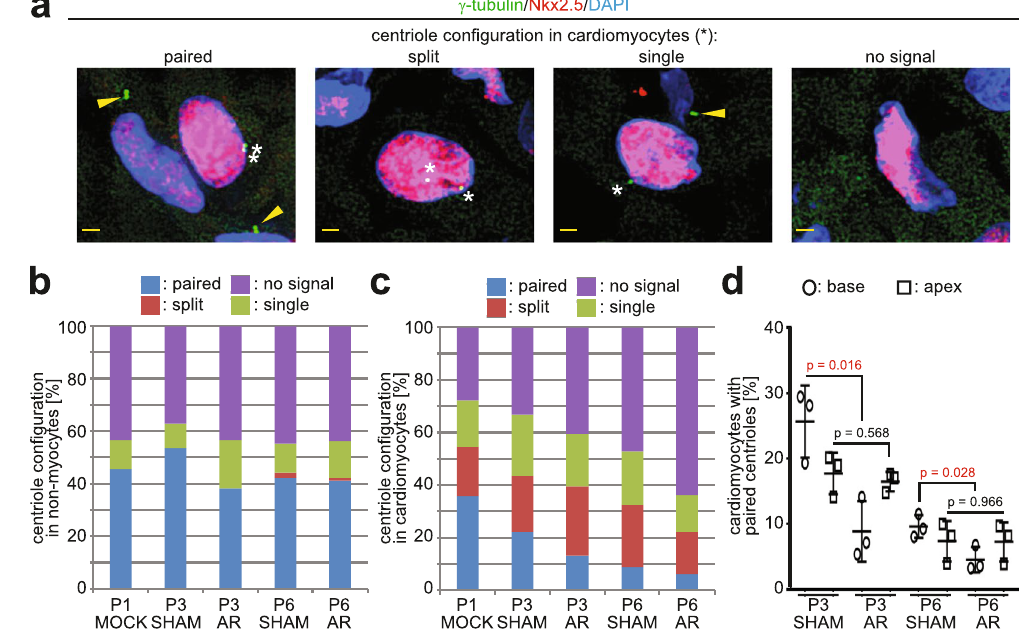
Figure 1. Effect of AR on cardiomyocyte centrosome disassembly. ( a ) Representative images of centrioles ( γ -tubulin) in heart cryosections of P0 rat heart ventricles. Nuclei: DAPI. Cardiac nuclei: Nkx2.5. Arrowheads indicate paired centrioles in non-myocytes. Asterisk indicates centrioles in cardiomyocytes. Paired-centrioles: doublet γ -tubulin signals within 2 μ m of one another; split-centrioles: γ -tubulin signals greater than 2 μ m of one another; single-centriole: single γ -tubulin signal with no identifiable pair (e.g. other centriole is either overlapping or split to the extent of no longer residing in the section); no-centriole: no identifiable, nuclear- proximal, γ -tubulin signal in the section. Scale bars: 2 μ m. ( b , c ) Quantitative analysis of centriole signals and configurations in non-myocytes ( b ) and cardiomyocytes ( c ) from cryosections of P0 (MOCK) and P3 or P6 (SHAM and AR) rat heart ventricles. Results are from three independent animals. ≥ 200 cardiomyocytes and ≥ 100 non-myocytes, collectively, from basal and apical regions were analyzed per experimental condition (see also Supplementary Fig. 1). ( d ) Quantitative analysis of cardiomyocytes proximal (within 1 mm) to base or apex/resection with paired centrioles from cryosections of P3 or P6 (SHAM and AR) rat hearts. Data are ± SD. p-values were calculated using two-tailed Student’s